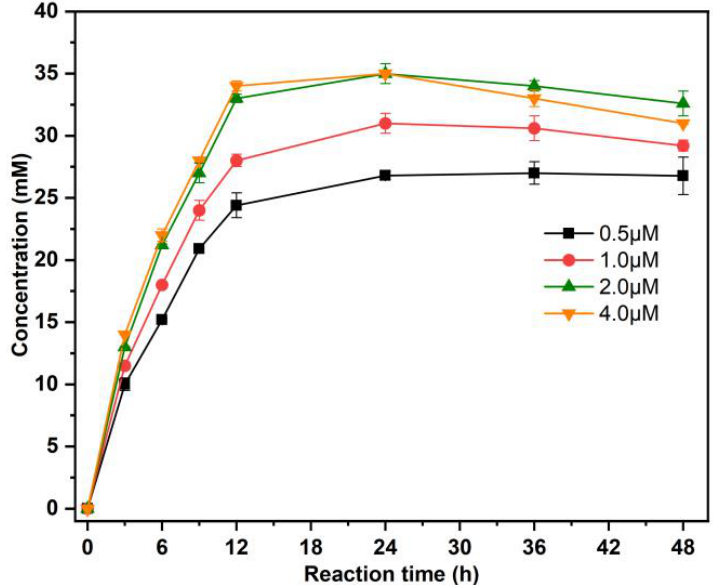
Figure 3. Effect of Aae UPO enzyme dosage on the oxidation of veratryl alcohol. (Reaction conditions: [ Pe AAOx] = 30 µ M, [ Aae UPO] = 0.5, 1.0, 2.0 and 4.0 µ M, [veratryl alcohol] = 50 mM (pre-dissolved in acetonitrile), 30 ◦ C, pH 7 and 500 rpm).